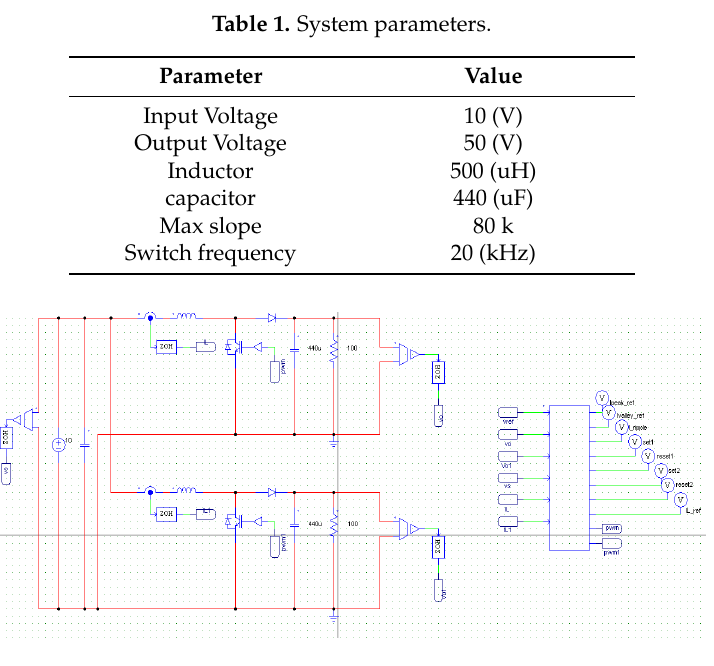
Figure 17. Response time for different controllers. Figures 18 and 19 show the inductor current waveform when the output voltage is lowered and raised, respectively, using the proposed hybrid current mode control. Section A is the inductor current waveform before the output voltage changes from high to low and Section B shows the inductor current waveform after the output voltage changes from high to low. It can also be confirmed that the current bandwidth changes with changing input/output voltage. Existing conventional hysteresis current mode control makes use of a fixed band gap, which causes the frequency to fluctuate when the output voltage is changed. However, since the proposed hybrid current mode control changes the current bandwidth at the same time that the output voltage changes, it can be seen that the controller operates stably without changing frequency.